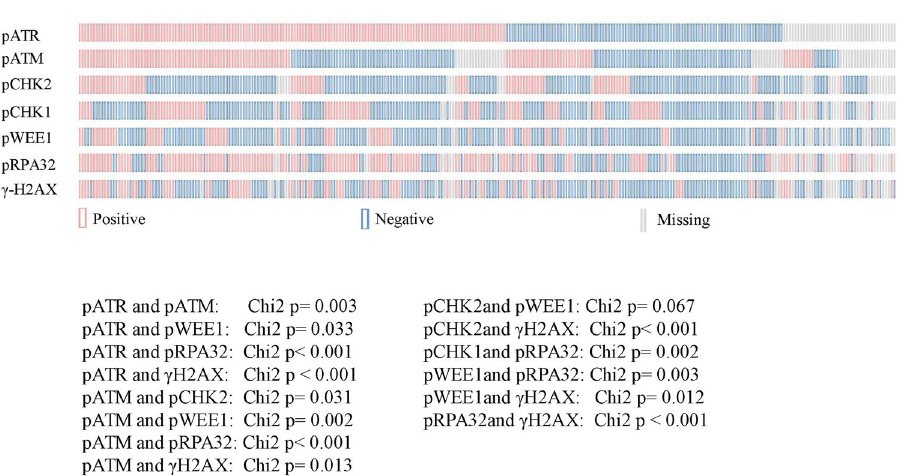
Figure 3. OncoPrint showing the associations between DDR-related biomarkers in male breast cancer. Statistically significant or borderline significant associations are